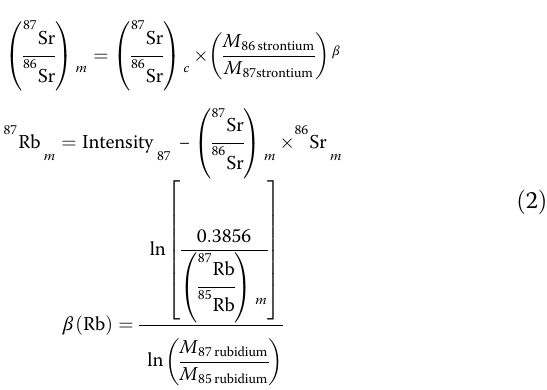
The calculated β (Rb) and β (Sr) for SRM 610 and SRM 612 in session 1 are plotted in Fig. 4. As shown here, there were weak to moderate correlations between β (Rb) and β (Sr). The correlation coefficient ( R 2 ) and the difference between β (Sr) and β (Rb) calculated for each analytical session are summarized graphically in Fig. 5. Spot-by-spot data and regression parameters are listed in Table S1. The R 2 values of NIST SRM 610 var- ied significantly from 0.74 to 0.26 (session 1, n = 14), 0.57 to 0.04 (session 2, n = 23), 0.58 to 0.11 (session 3, n = 17), 0.71 to 0.17 (session 4, n = 17), and 0.61 to 0.29 (session 5, n = 10). This was also true for SRM 612 ( R 2 = 0.36 – 0.02, n = 15). As displayed in Fig. 5, β (Sr) was consistently higher than β (Rb), except for data obtained in session 2.